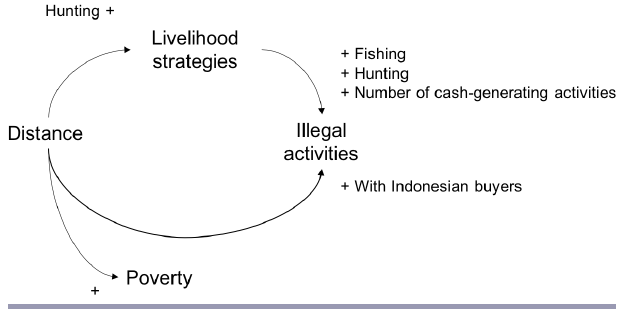
Fig. 6 . Causal loop diagram of the main drivers (+ positive, - negative) of illegal activities (fishing and/or trading) in the South Fly Villages.